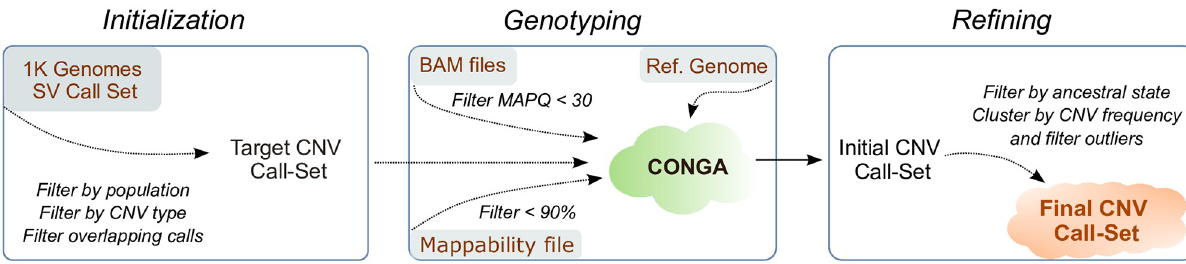
Fig 1. Overall workflow of CONGA. The first step involves initialization, where we create the input (reference) CNV file using deletions and duplications identified in high quality genome sets. We apply CONGA-genotyping in the second step and create the initial CNV call set. We then perform filtering and refining steps, and thus generate the final CNV call